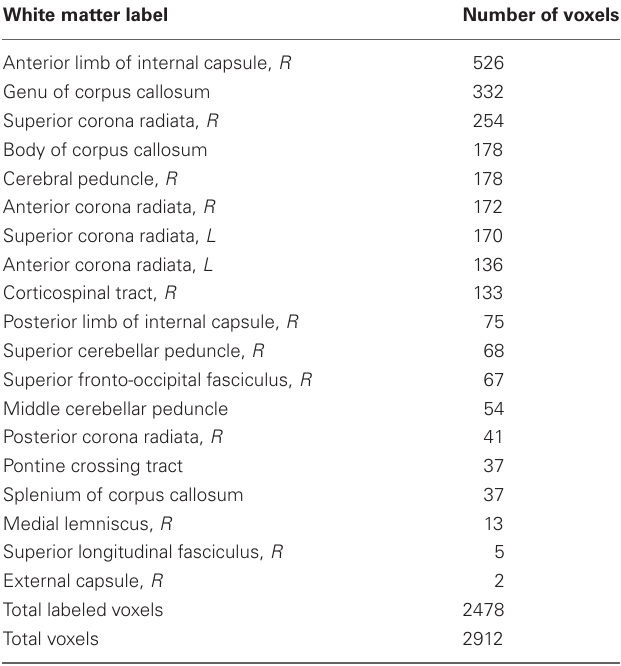
Table 2 | Locations of voxels showing RD decreases.